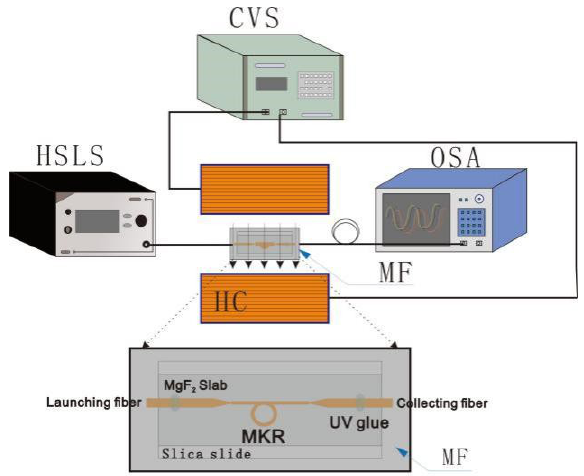
Figure 2. Schematic of the experimental setup for investigating the sensing properties.